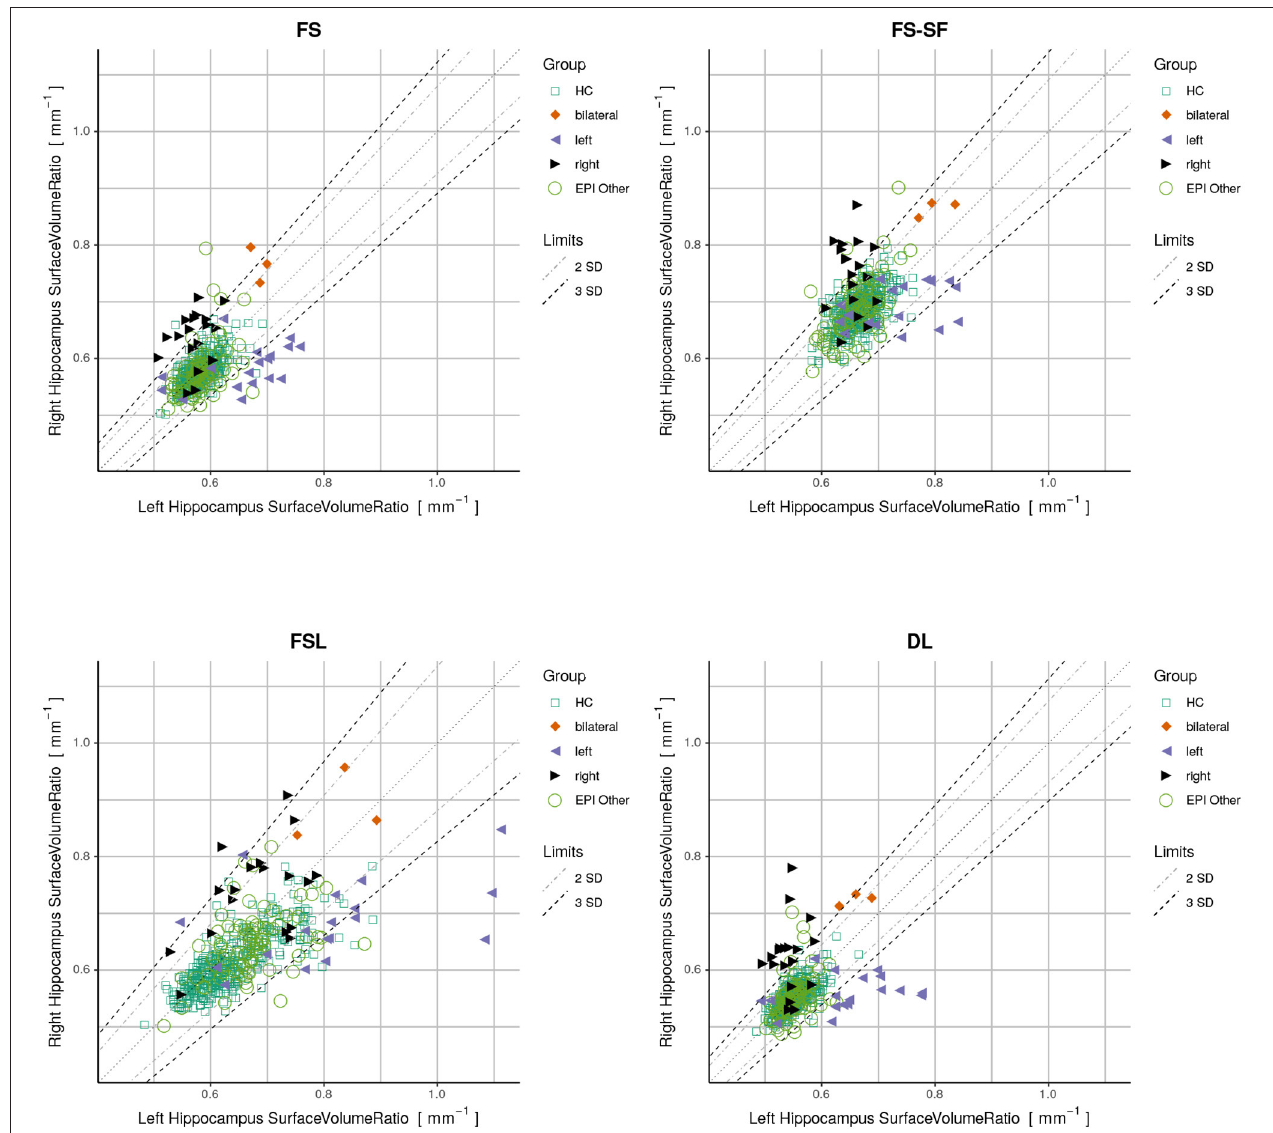
FIGURE 4 | Plots displaying surface-to-volume ratio of left (x-axis) and right (y-axis) hippocampi derived from the four segmentation methods. Healthy controls (HC), hippocampal sclerosis (bilateral/left/right), and all-other-epilepsies (EPI Other) are color-coded. Limits showing two and three standard deviations (SD) calculated on the